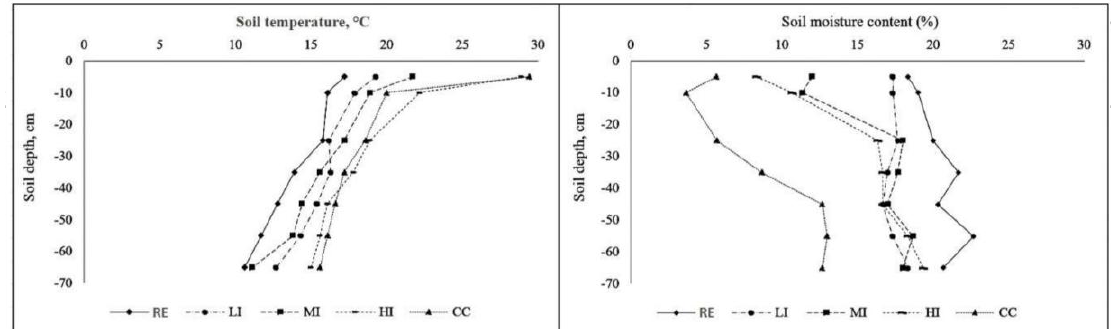
Figure 5. Soil temperature and moisture at different depths in the soil profiles.